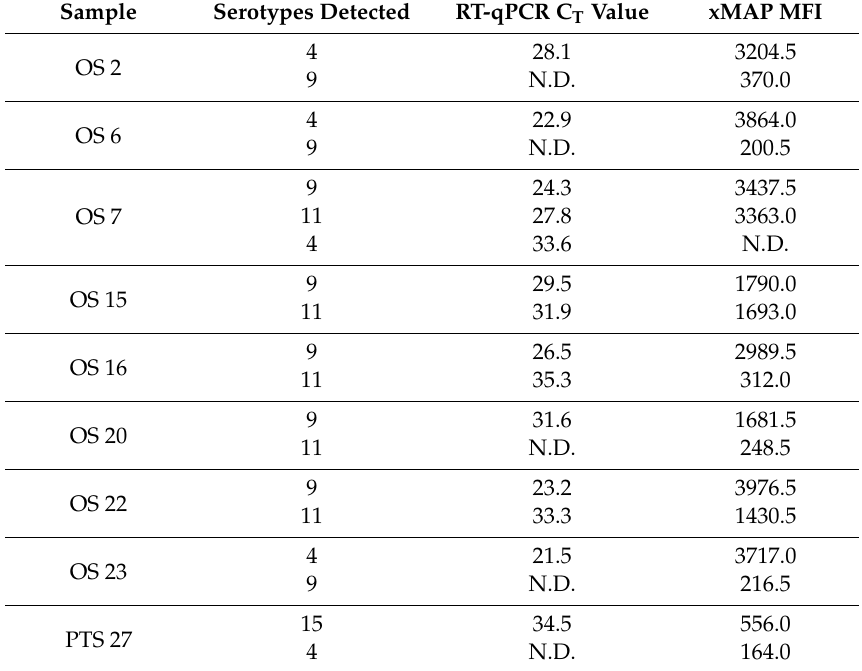
Table 3. Performance of serotype-specific RT-qPCR assay and xMAP assay on samples containing multiple